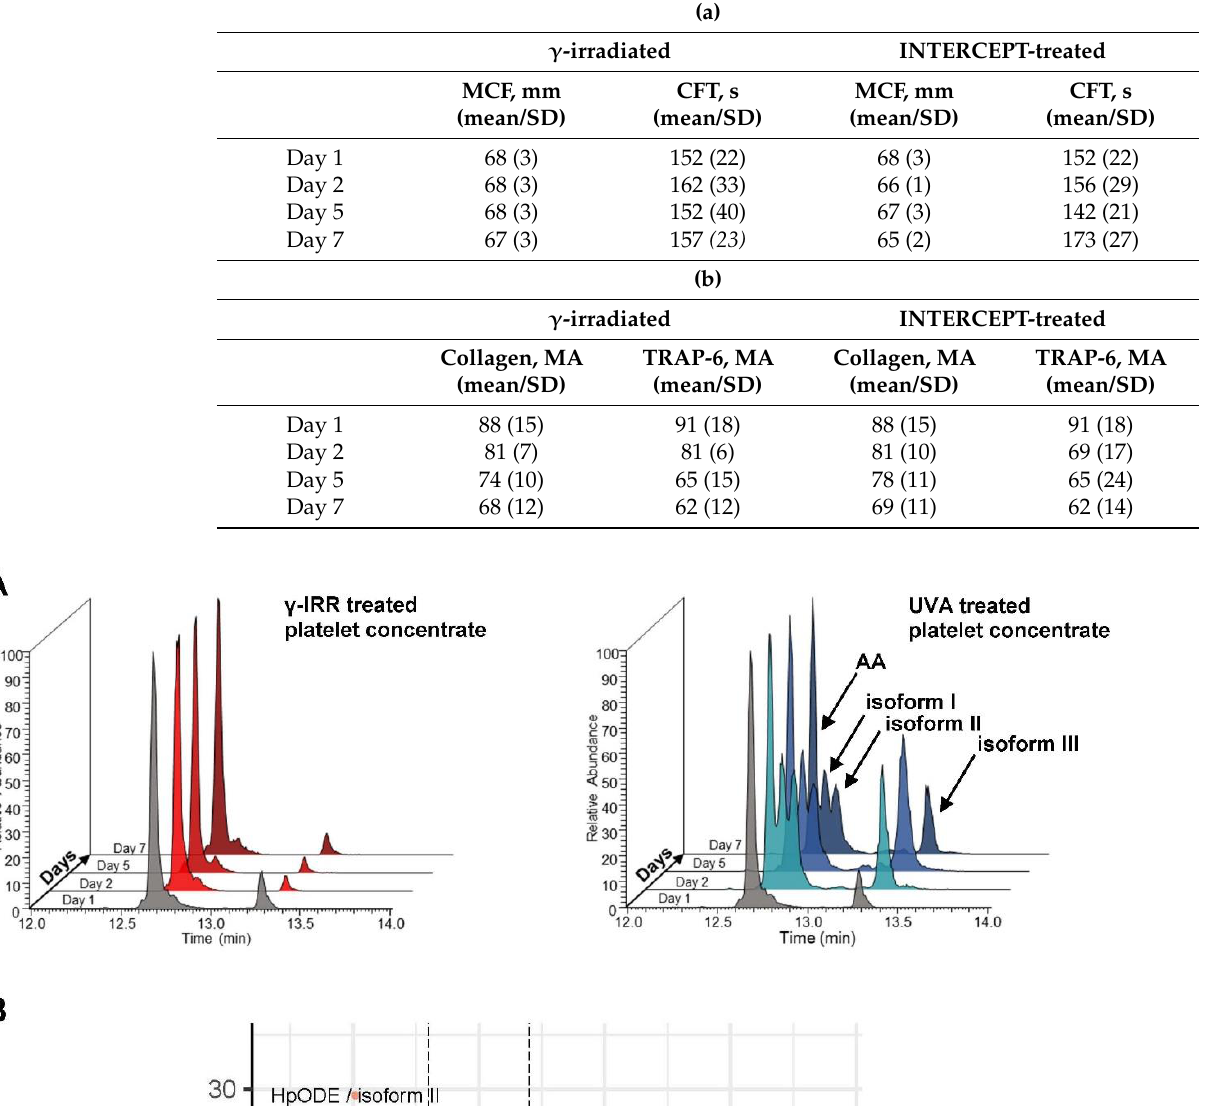
Figure 2. ( A ) INTERCEPT treatment, but not γ -IRR, is accompanied by the formation of trans -ara- chidonic acid isoforms. ( B ) Immediate effects of INTERCEPT treatment versus γ -IRR at day 2 are